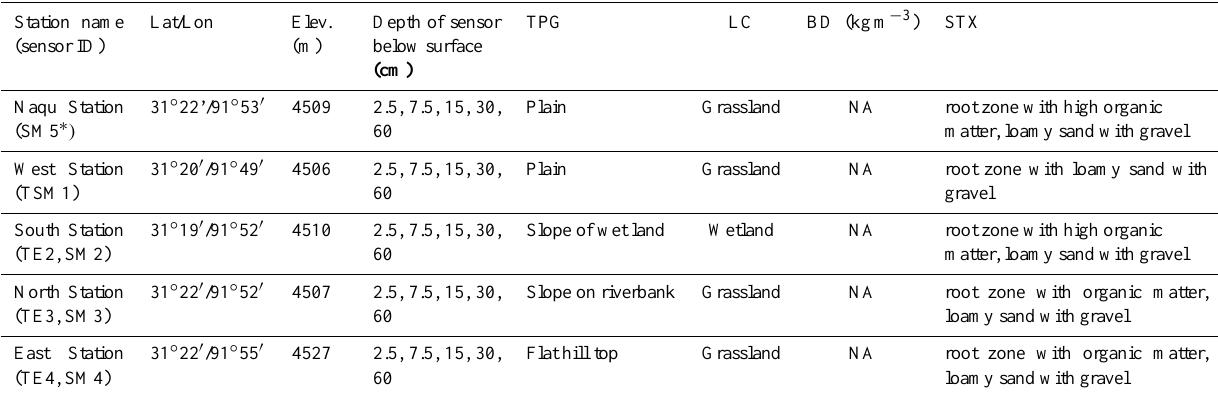
Table 1. Naqu network station information (station name, geographical coordinates, elevation above mean sea level (a.s.l.), depth of probes, location topography (TPG), land cover (LC), soil bulk density at 5cm depth (BD), soil texture at 5–15cm depth (STX), soil organic matter content at 5-15 cm depth (OMC), Not Available (NA)).